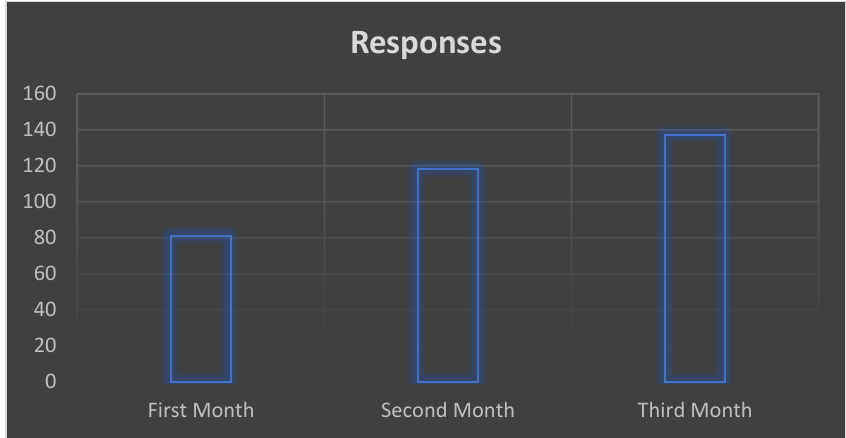
Figure 5. Monthly number of responses.